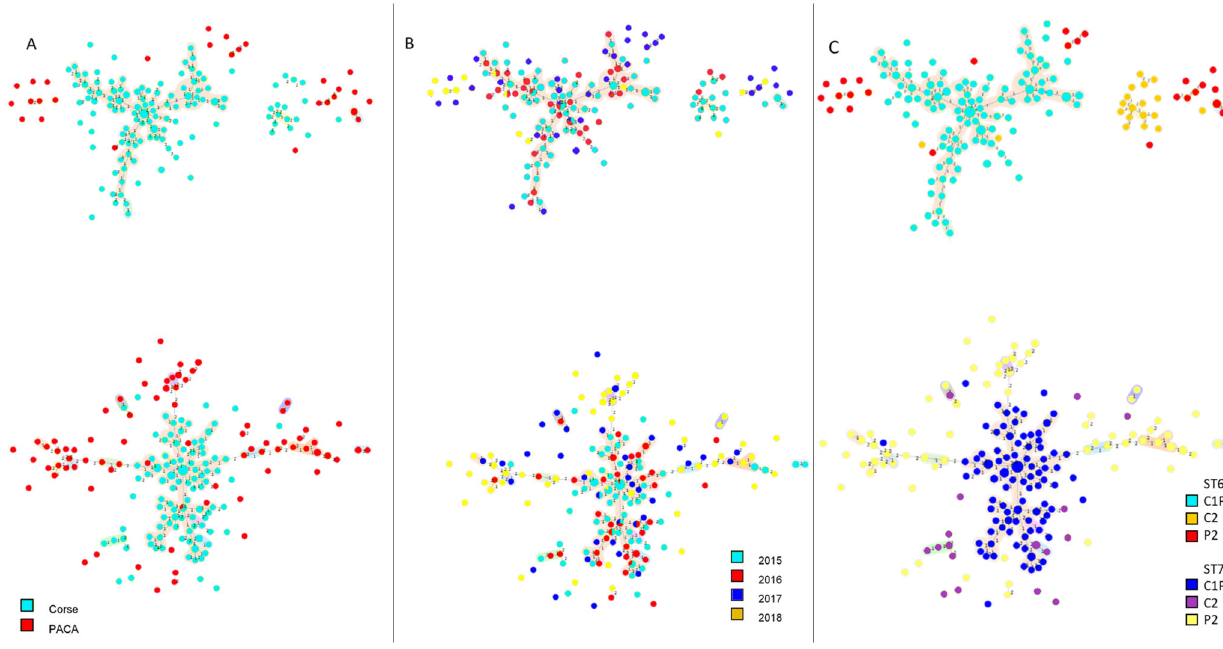
Fig. 2 Minimum spanning trees of the 396 French X. fastidiosa subsp. multiplex infected samples typed using the VNTR-13 scheme. Dot diameter represents the number of strains per haplotype. Link number refer to the number of TR loci polymorphic and distinguishing two haplotypes. Dot colors refer to A sampling region; B year of sampling; C ABC grouping. Colored area around haplotypes the clonal complexes.